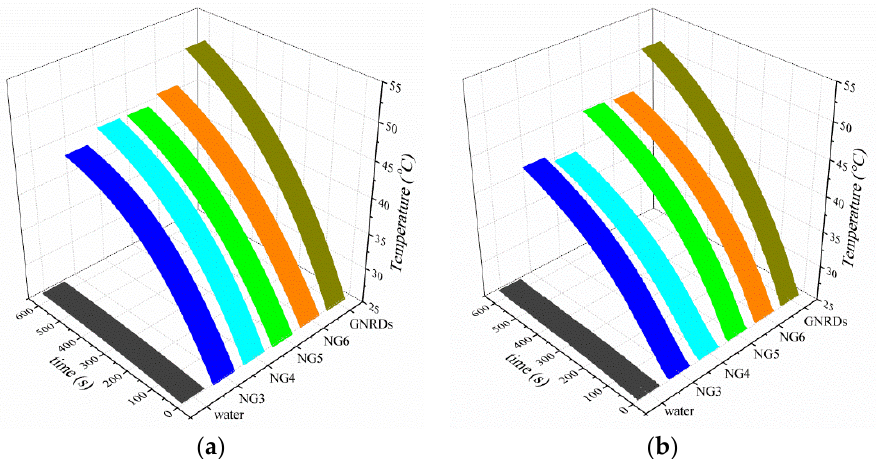
Figure 8. In situ photothermal effect monitoring of solution of: ( a ) GNRDs/CDDP-loaded nanogels, ( b ) GNRDs/DOX-loaded nanogels.